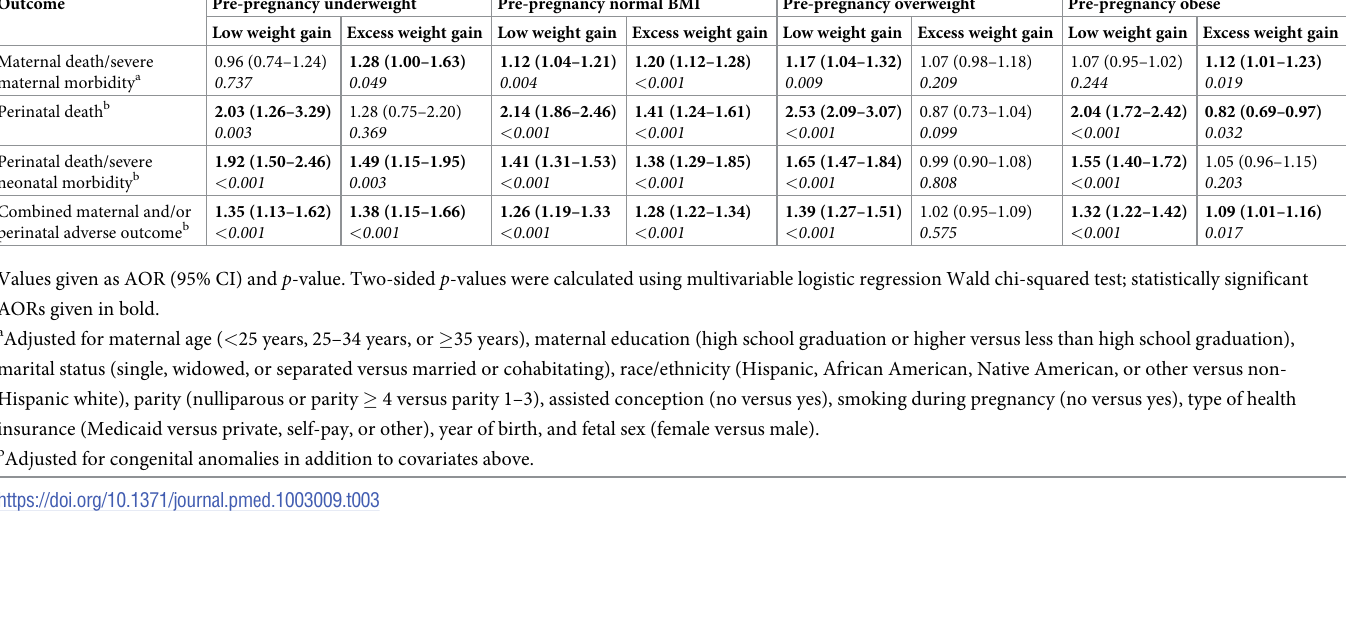
composite adverse perinatal outcome—perinatal death and severe neonatal morbidity—than women with optimal weight gain (Table 3). Among women with low weight gain, the odds of stillbirth was significantly elevated in all pre-pregnancy BMI categories, except for a non-statis- tically-significant increase in underweight women (S4 Table). Table 3. Adjusted odds ratios (AORs) for severe adverse birth outcomes by gestational weight and pre-pregnancy BMI—Singleton births, Washington State, 2004– 2013 (AOR relative to optimal weight gain in each pre-pregnancy BMI category).